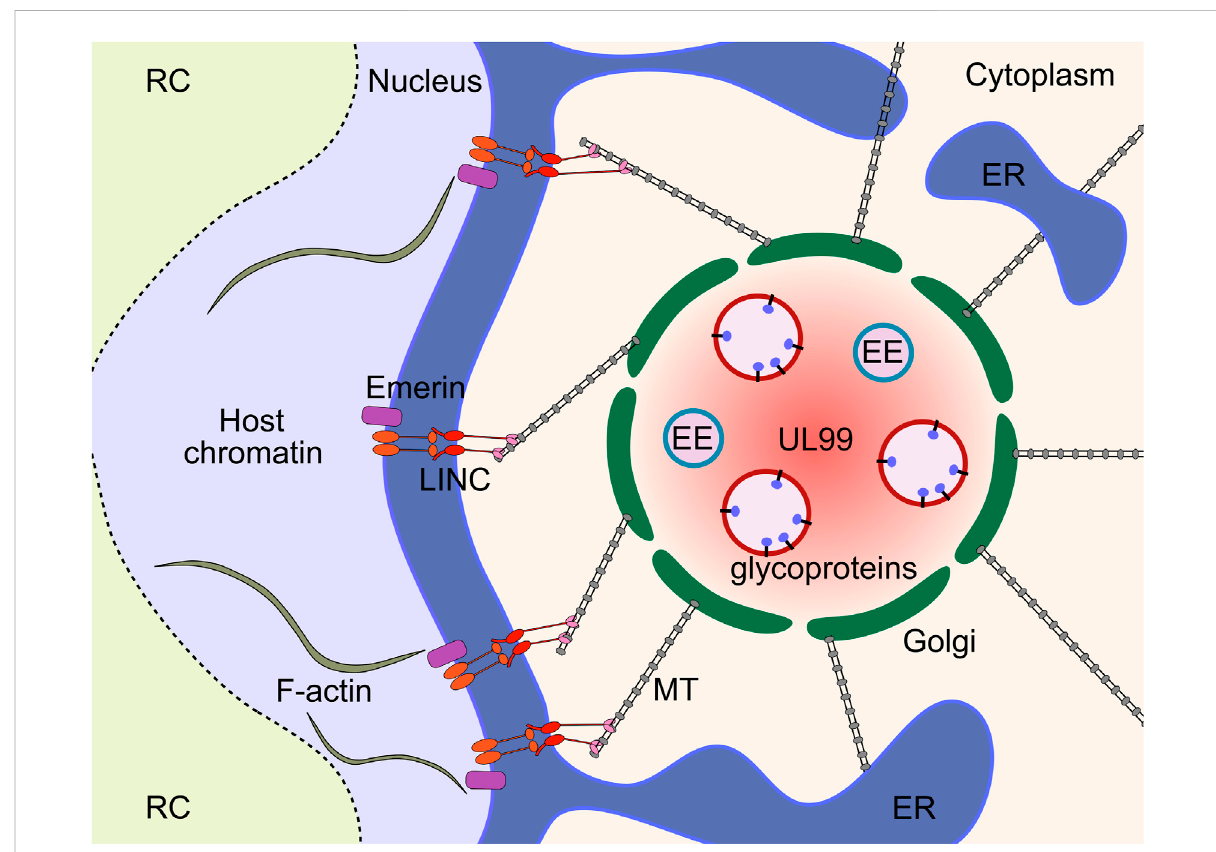
FIGURE 6 TheHCMVvACisacytoplasmicvirusfactorywherevirioncargoaccumulatestoenabletegumentationandsecondaryenvelopment.ThevACis characterised by concentric rings of host-derivedorganelles, with endosome membranes surrounded by aGolgi ring, and the ER loosely associated around the periphery. The structure is adjacent to the enlarged kidney-shaped nucleus and functions as a Golgi-derived MTOC. The cytoskeleton is central to vAC formation and function, and is connected to the nucleus through polarised LINC complexes. LINC complexes provide a bridge between thenucleoskeleton and cytoskeletonthat allowsthevAC to exert control over nuclearmorphology, rotation, and internal